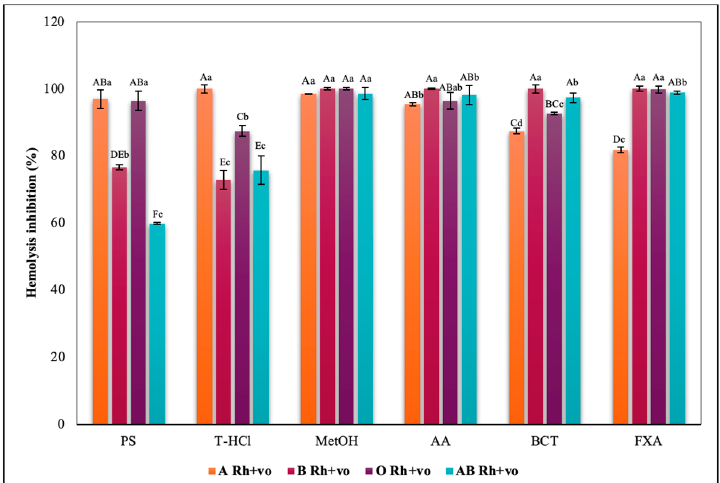
Figure 9. Inhibitory effect of hypotonicity-induced hemolysis of P. cruentum extracts on human erythrocytes with different ABO blood groups. Different letters represent significant differences in the means between treatments and groups ( p ≤ 0.001). Capital letters represent a two-way ANOVA. Lowercase letters represent a univariate ANOVA between the extracts. PS, extract of physiological solution; T-HCl, 0.5 M Tris-HCl extract; MetOH, 99% methanol extract.